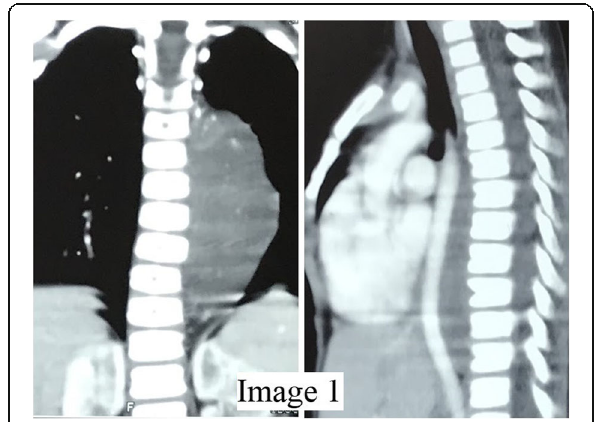
Fig. 1 Contrast-enhanced CT of the child showing the extent of left thoracic mass with specks of calcifications. In the lateral view, the